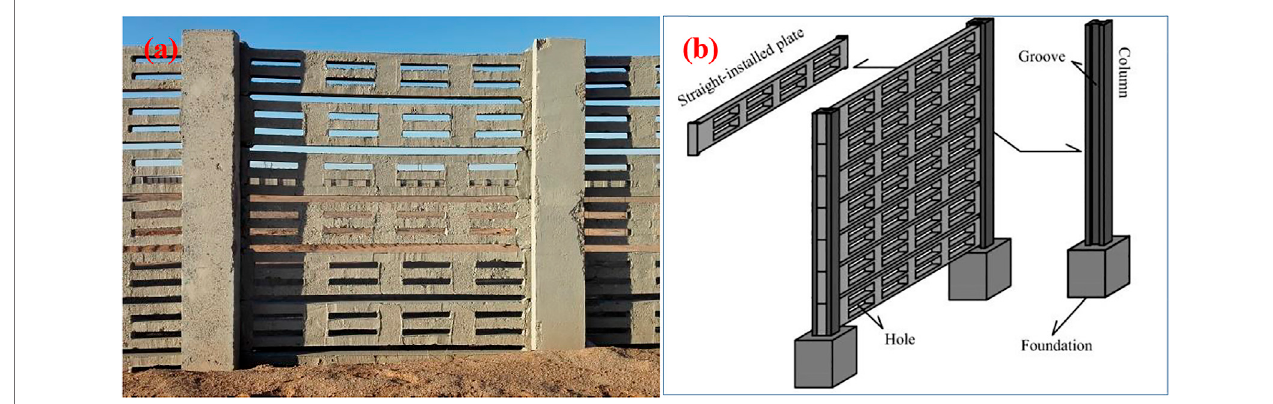
FIGURE 2 | (A) Concrete plate-insert sand fence and (B) schematic diagram of the fence structure (Shi et al.,